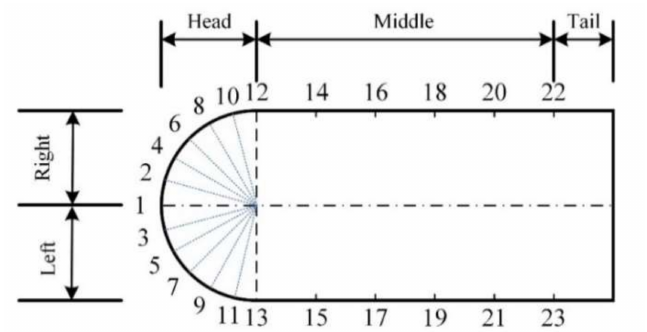
Figure 1. Sensor position distribution on the horizontal plane of the carrier.